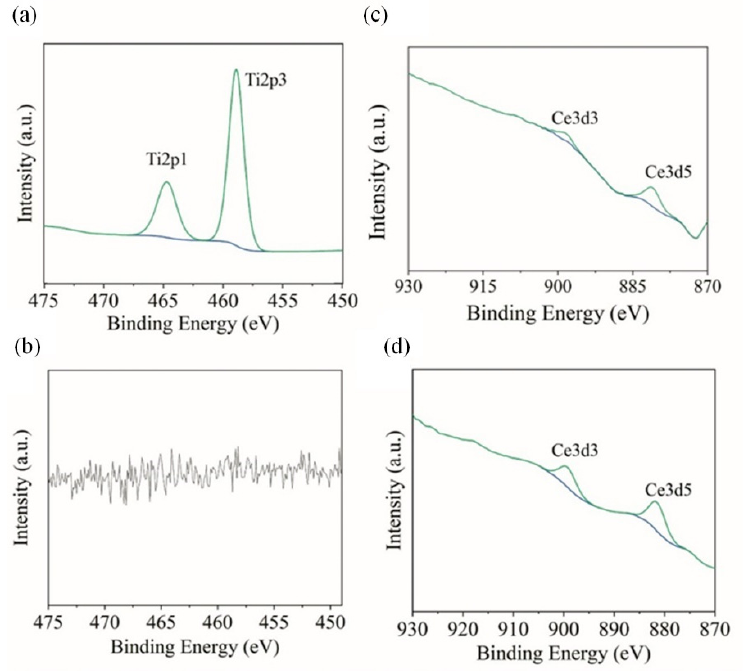
Figure 11. High-resolution XPS spectra for Ti2p3 ( a , b ) and Ce3d5 ( c , d ) registered before corrosion tests ( a , c ) and after 3.5 month of immersion in 0.5 M NaCl ( b , d ).